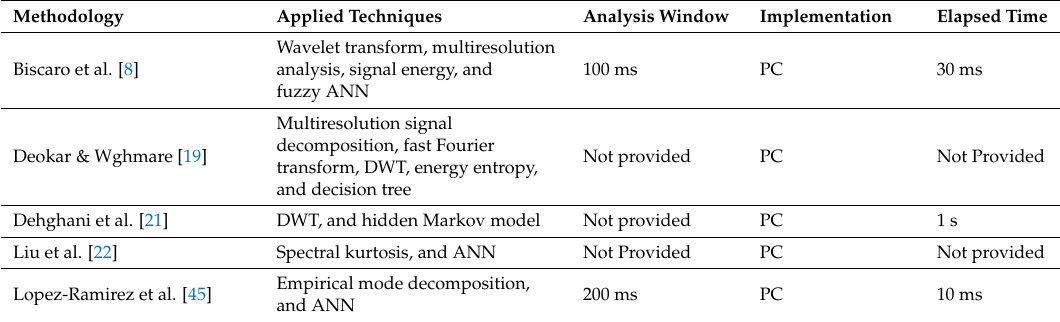
Comparison chart of the introduced methodology against previous studies of PQD